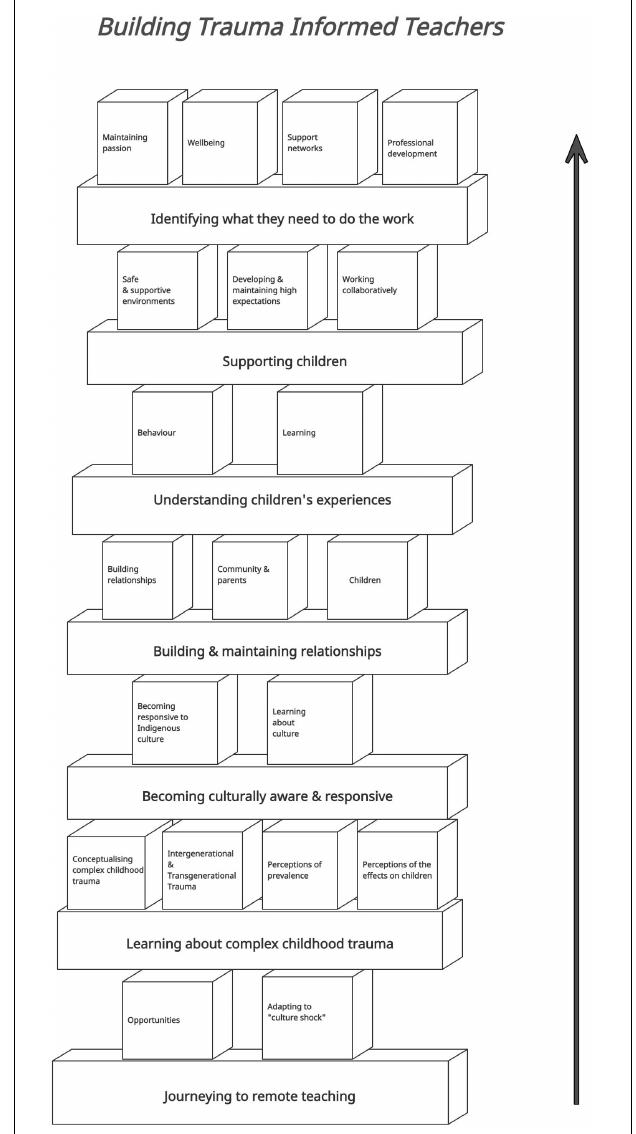
FIGURE 1 | Building trauma informed